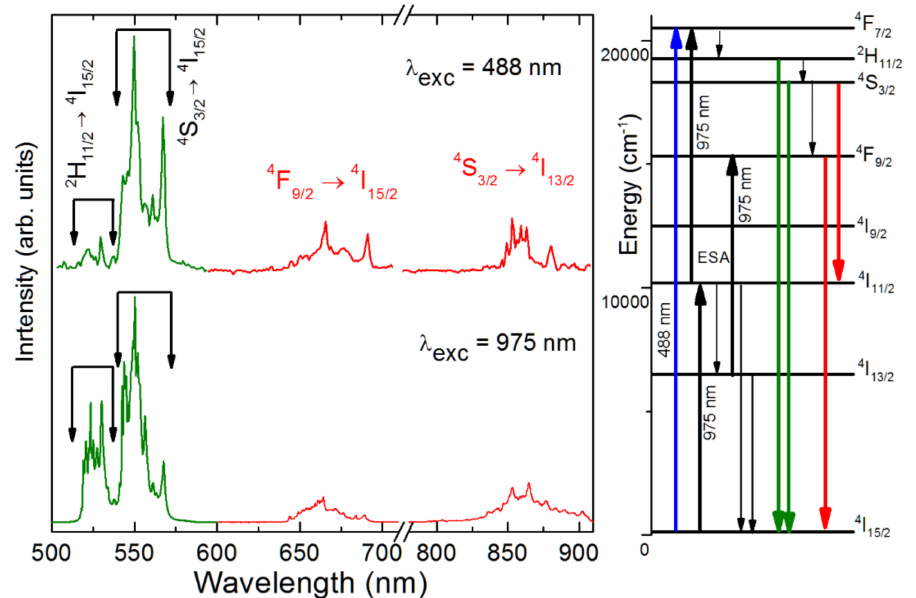
Figure 2. Luminescence spectrum of the phosphor with nominal composition La 2.9 Er 0.1 NbO 7 ob- tained at ambient conditions under 488 nm (upper) and under 975 nm laser excitation (lower). Main transitions are indicated in the upper spectrum. On the right side, a simplified level scheme of Er 3+ ion is sketched showing the excitation and de-excitation channels. The inset in the lower spectra shows an example of the upconverted intensity versus excitation power obtained for the emission at 850 nm, showing a slope of 1.5. Similar results were previously reported for green and red upconverted bands